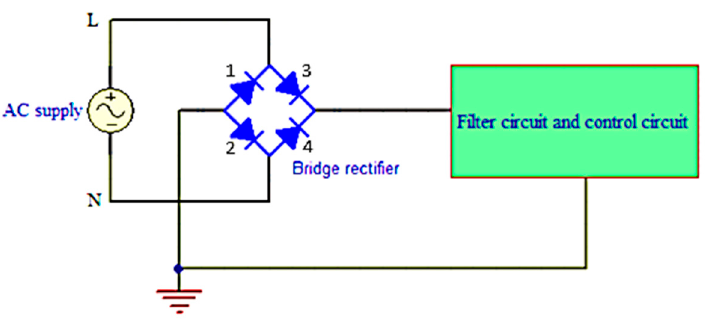
Figure 5. Principle of the bridge rectifier in an LED drive circuit. Numbers 1–4 denote diodes D 1 –D 4.